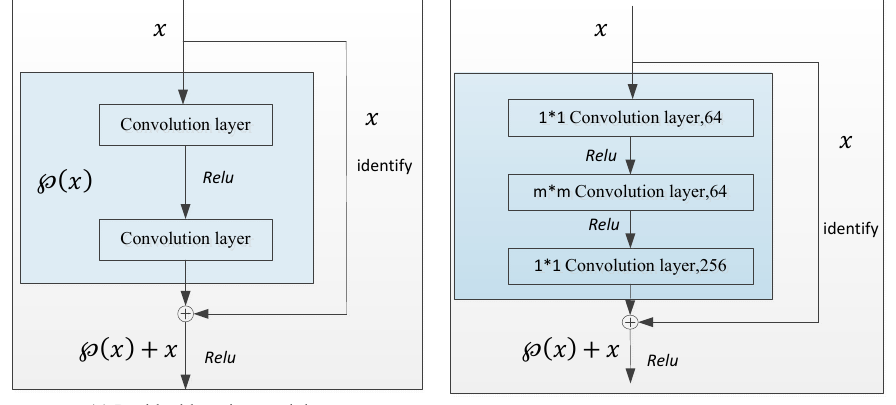
Figure 1. Residual learning network.